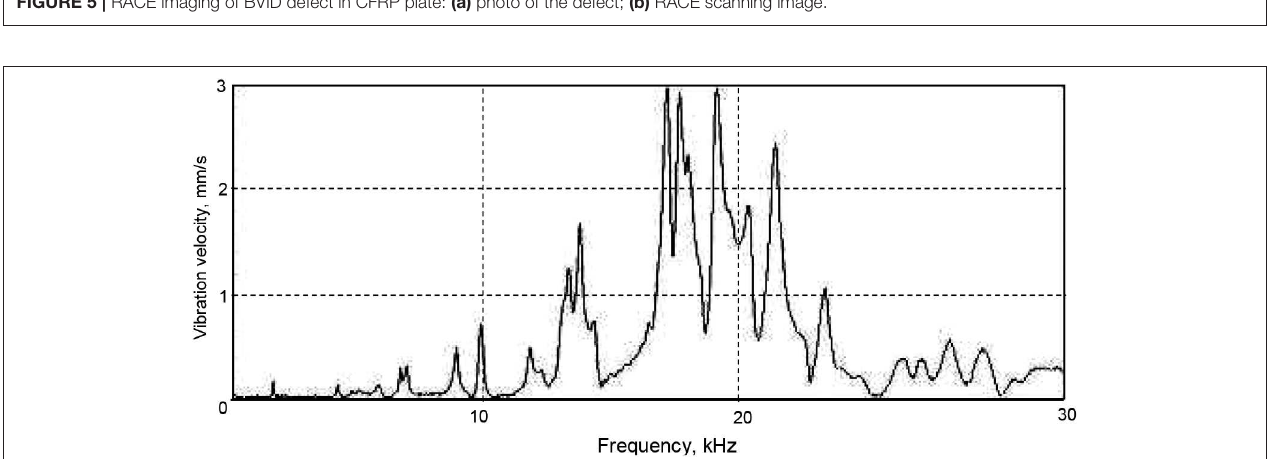
FIGURE 5 | RACE imaging of BVID defect in CFRP plate: (a) photo of the defect; (b) RACE scanning image.